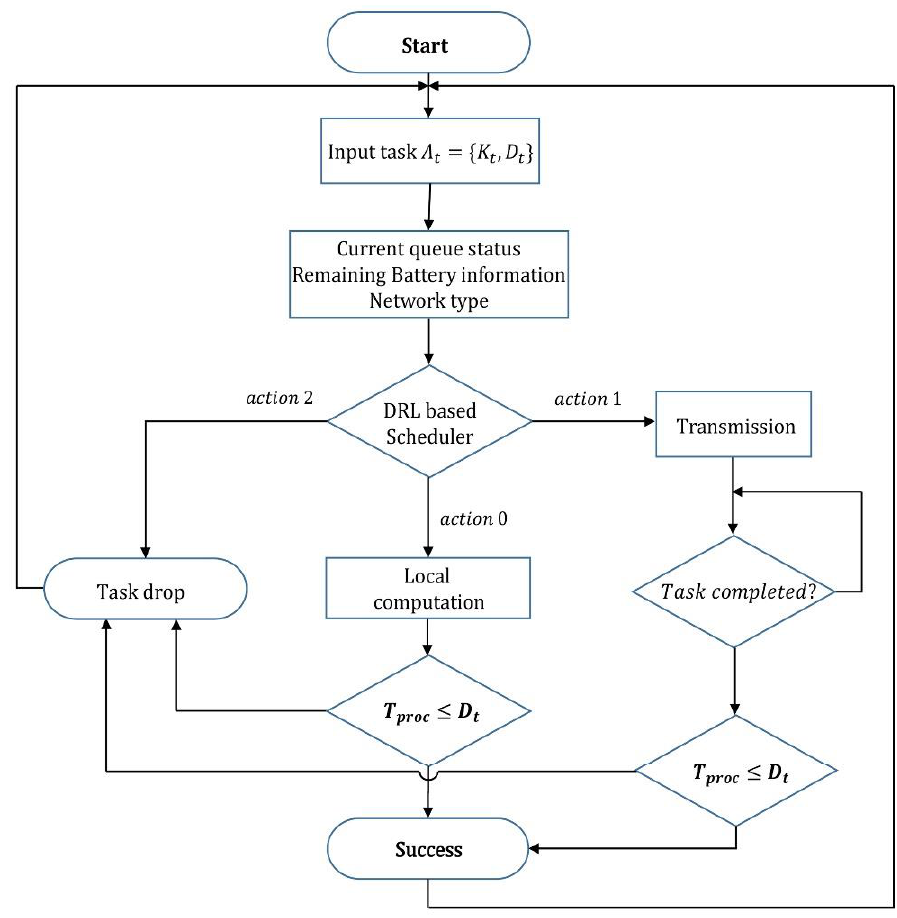
Figure 6. Scenario of the MEC system.